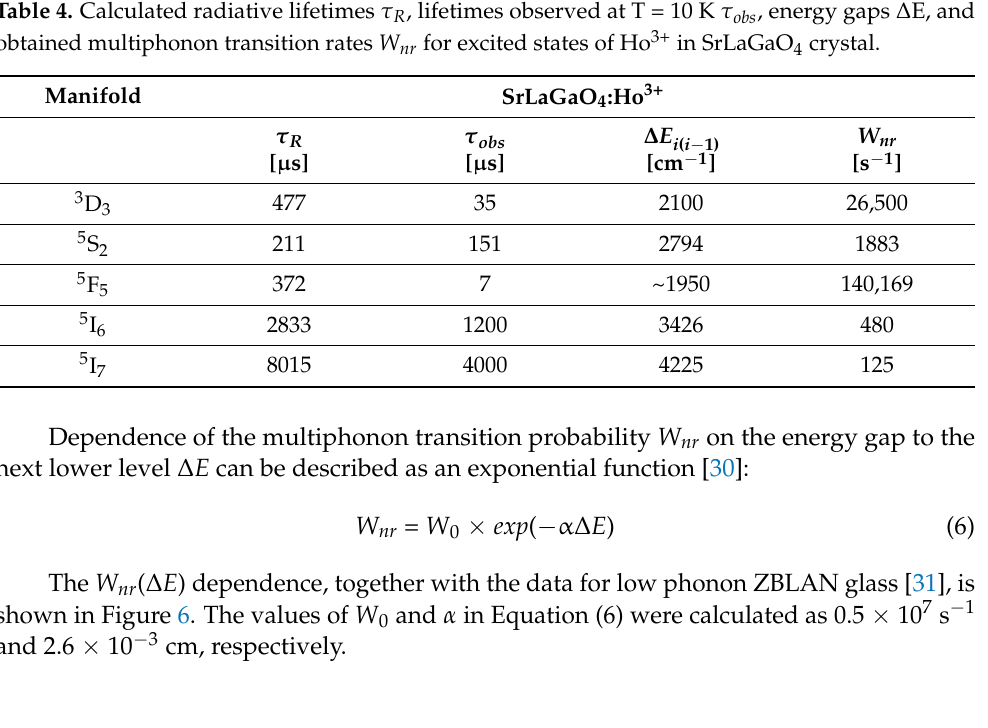
Calculated radiative lifetimes, measured at low temperature lifetimes, the energy gaps to the next lower level and the multiphonon transition rate for excited states of Ho 3+ in SrLaGaO 4 are shown in Table 4. Table 4. Calculated radiative lifetimes τ R , lifetimes observed at T = 10 K τ obs , energy gaps ∆ E, and obtained multiphonon transition rates W nr for excited states of Ho 3+ in SrLaGaO 4 crystal. Manifold